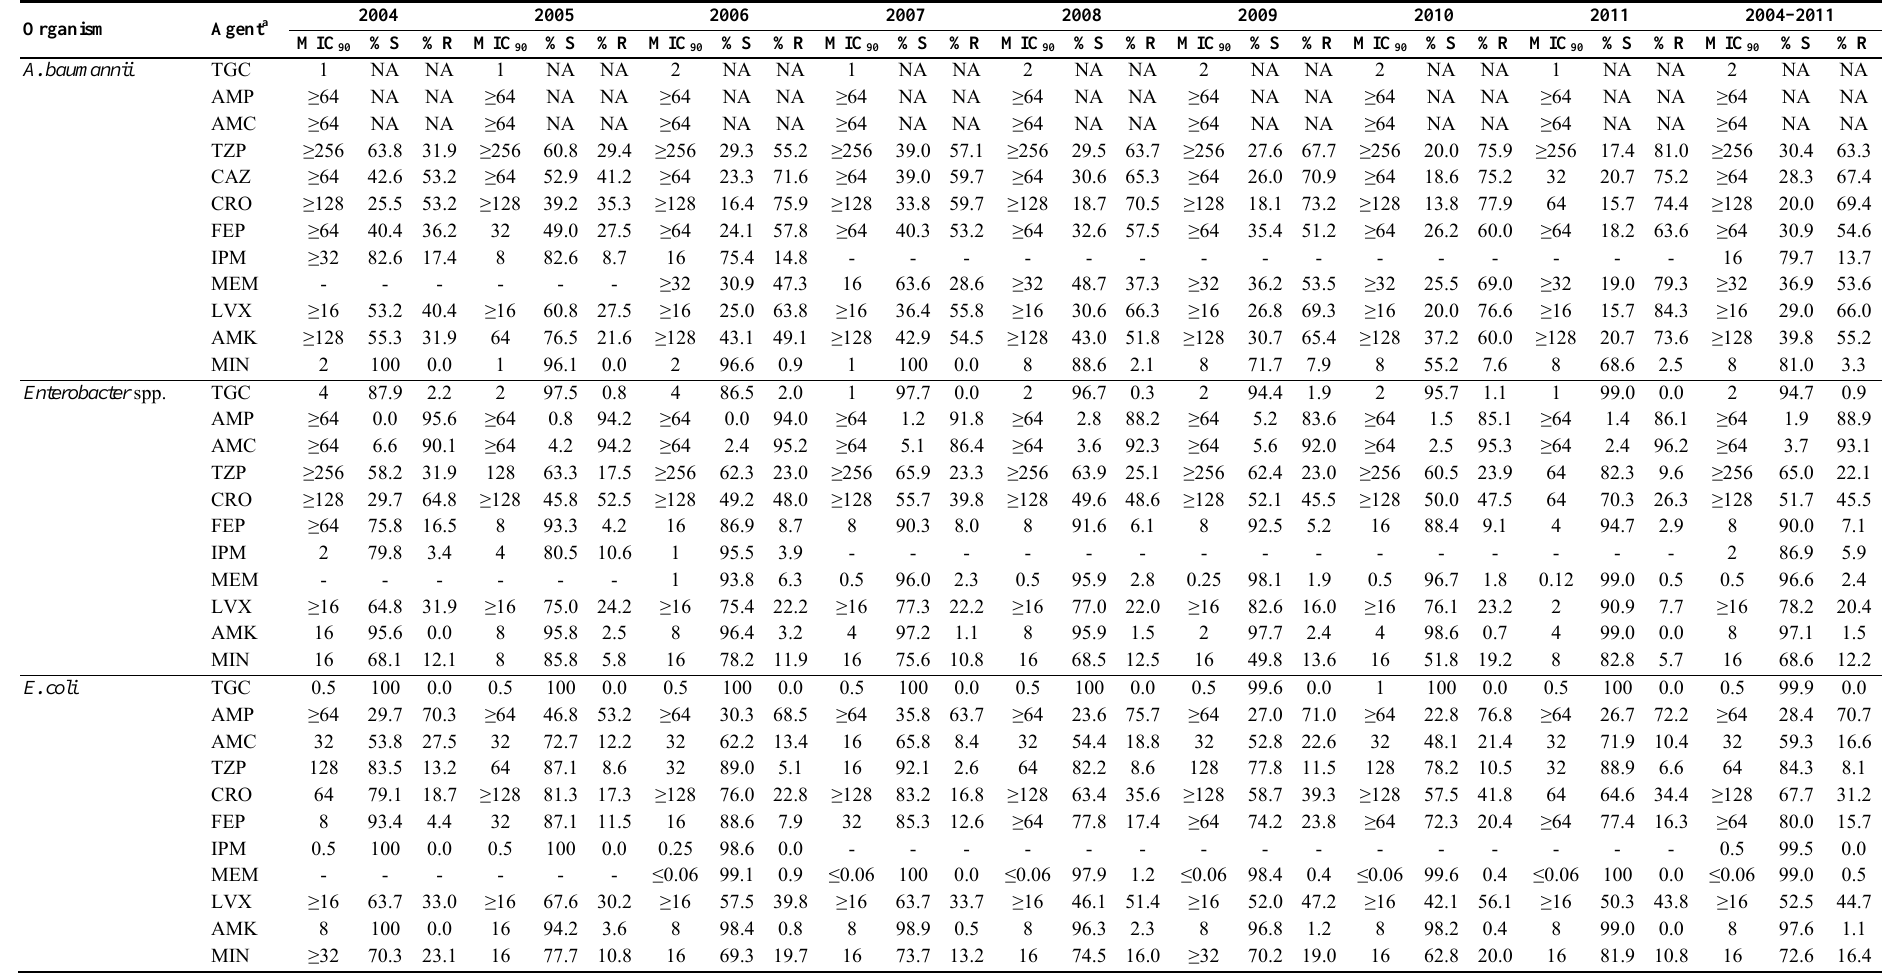
Table 2. Minimum inhibitory concentration (MIC) Gram-negative isolates collected in Italy during T.E.S.T.